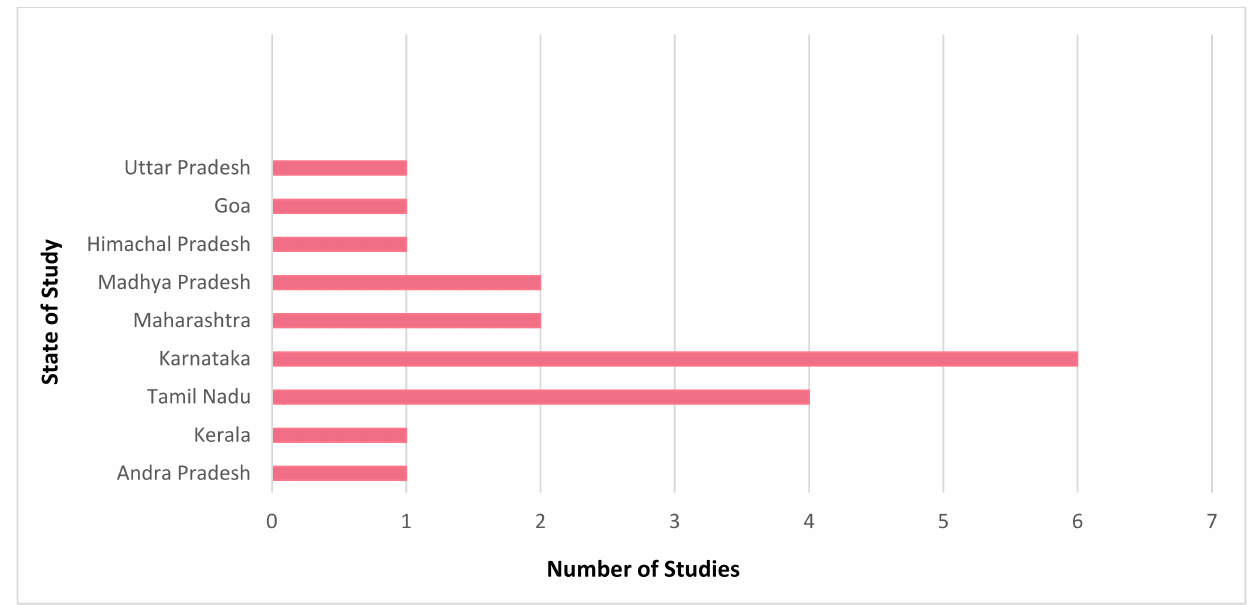
Figure 2. Selectednumber of studies conducted across different states in